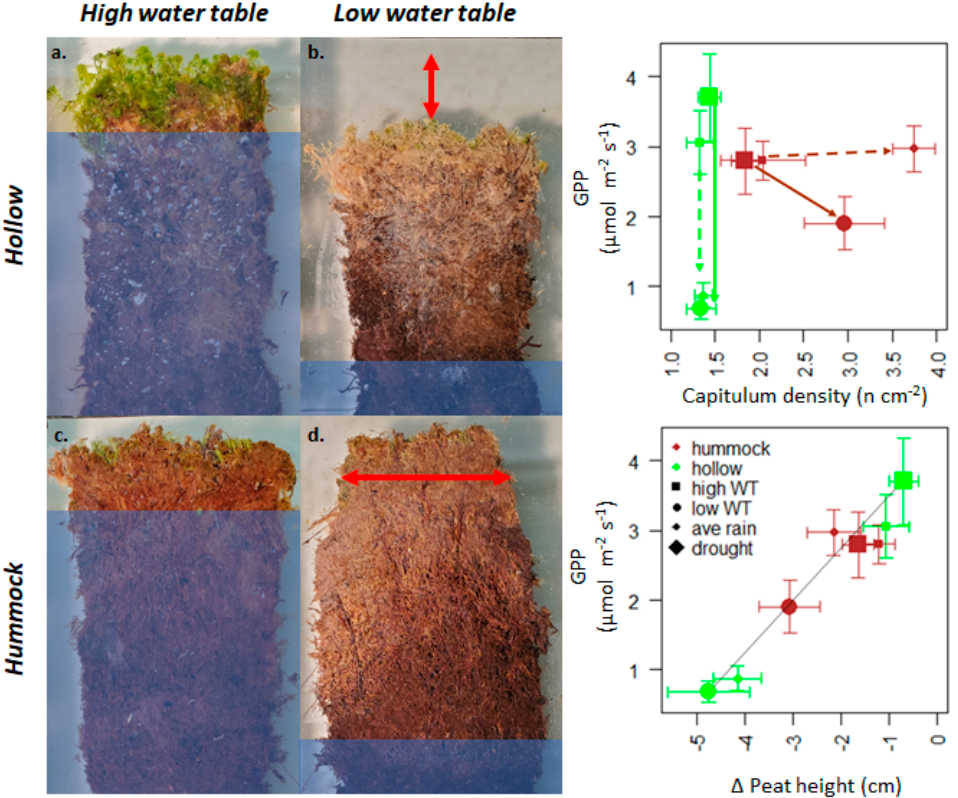
Figure 3. The relationship between water tables, peat structure and GPP. The images show Sphag- nocosm monoliths removed from the PVC collars and cut into cross sections, representing hollows ( a , b ) and hummocks ( c , d ), under high ( left ) and low ( right ) water tables. The shape of the monolith was reconstructed based on the measured decrease in peat height and increased density (inward compression) of capitula measured in situ, the pictured change shows the mean decrease in peat height or increased density from a high water table—average rainfall treatment to a low water table drought treatment, with the red arrows representing the primary axis of change in each image. The figures on the right show GPP in relation to e. capitula density and f. surface subsidence ( ∆ peat height). Error bars represent standard error. In the upper right graph, dashed arrows connect the the high and low water table treatments at average rainfall, while solid arrows connect the high and low water table treatments at drought, with colors representing the respective landforms. The line in the lower right figure represents significant linear fit across